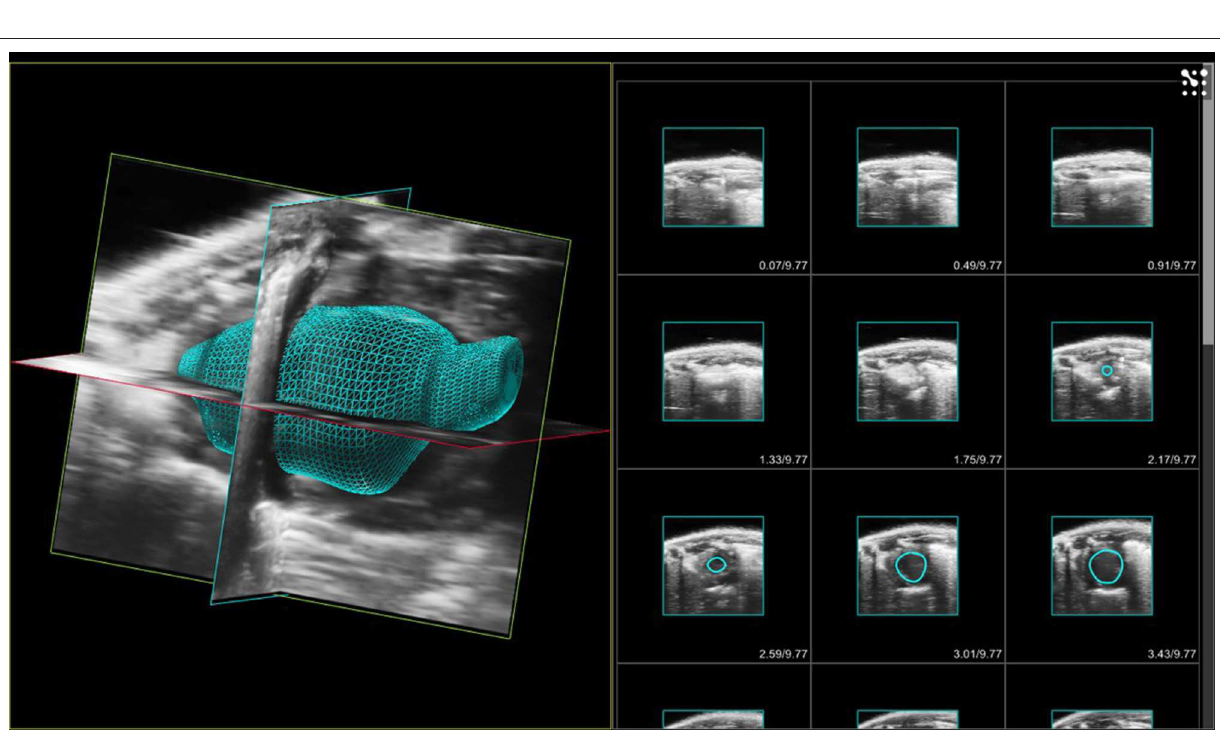
Frontiers in Physics | www.frontiersin.org